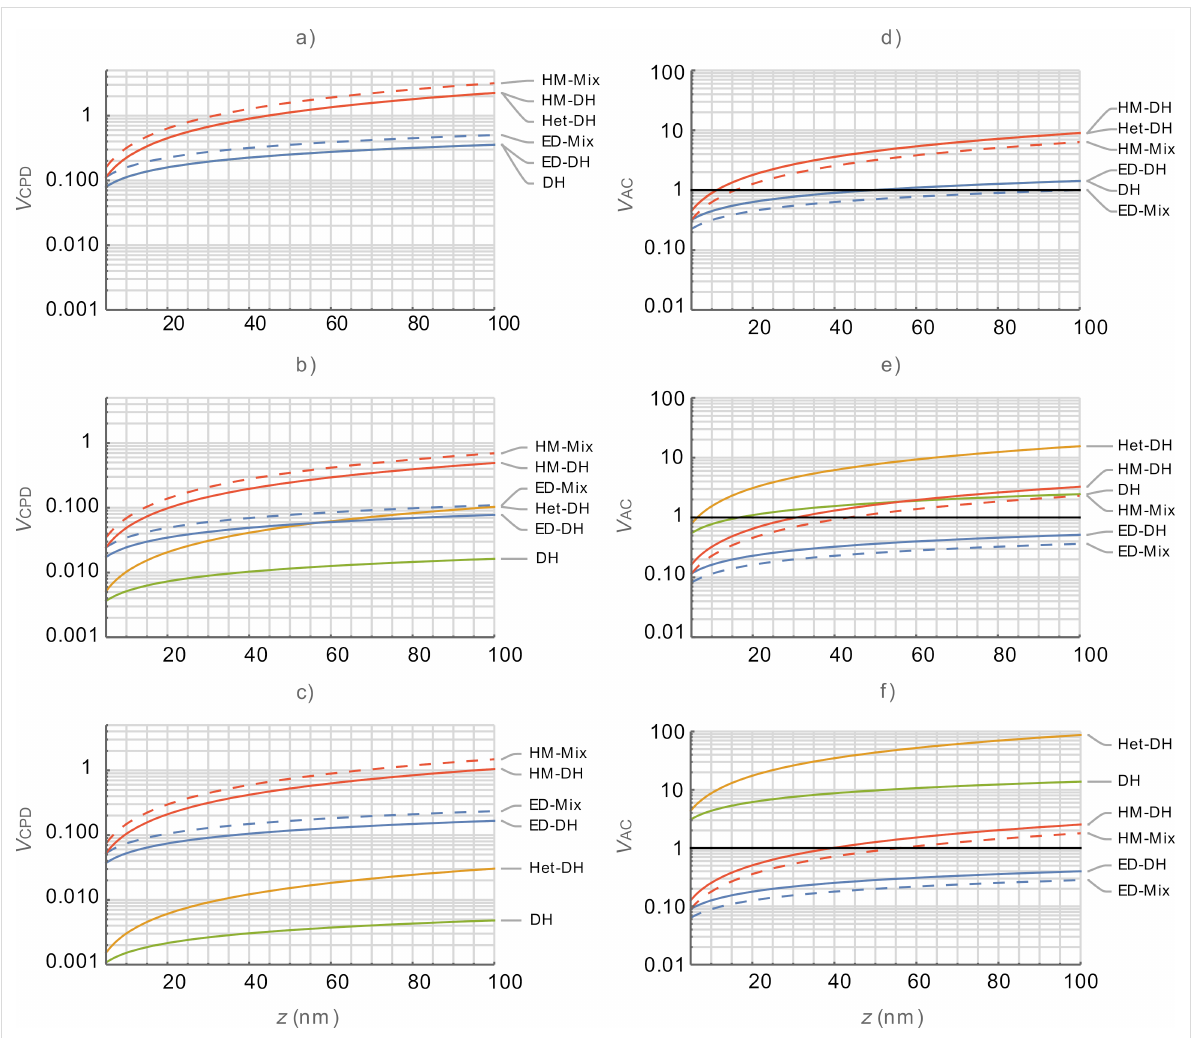
Figure 3: Comparison between multifrequency KPFM modes in air as a function of the tip–sample separation, z . (a–c) and (d–f) for the first harmonic electrostatic response occurring on ω off (top), ω 1 (middle), and ω 2 (bottom), respectively. DH (green), Het-DH (orange), ED (blue), and HM (red). Mixed responses are shown with dashed lines. is calculated at V AC = for all z . The black lines in (d–f) indicate V AC = 1.0 V. Lower bias is better for all